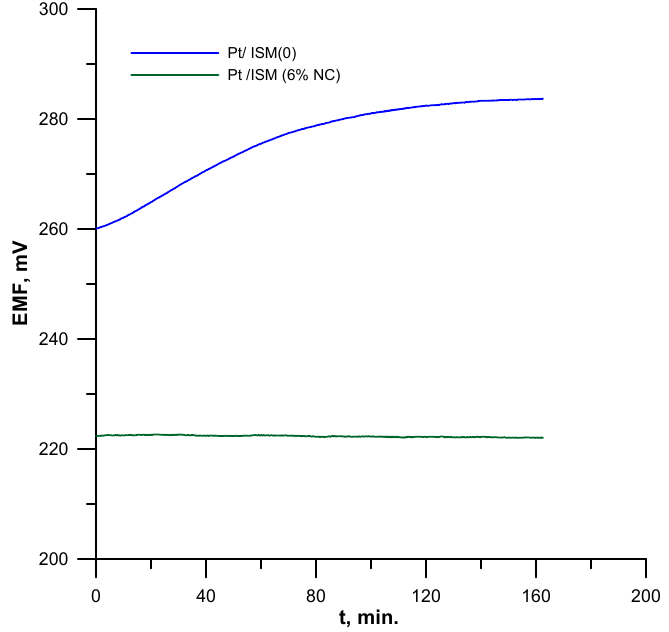
Figure 4. Short-term potential stability of the electrodes under zero current conditions. As can be seen, the Pt/ISM (6%NC) electrode with the nanocomposite-modified membrane is characterized by much more stable potential than the unmodified Pt/ISM